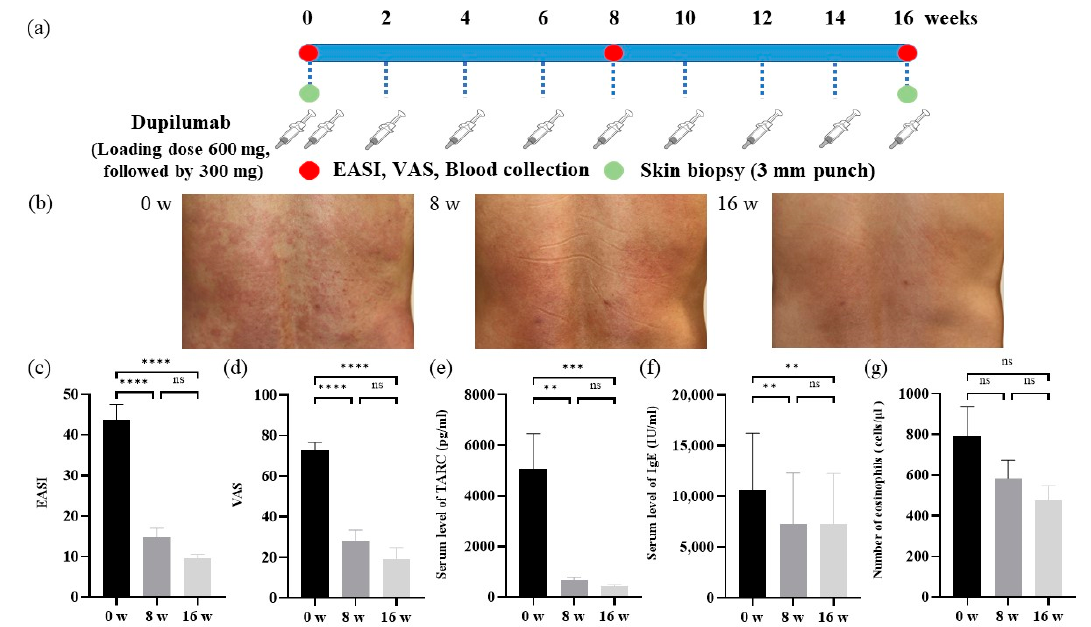
Figure 1. Experimental design and analysis of clinical scores in AD patients before and after the dupilumab treatment. ( a ) Experimental design. ( b ) Skin manifestations. 0 weeks ( left ). 8 weeks ( middle ). 16 weeks ( right ). ( c ) The EASI score. ( d ) The VAS scores. ( e ) TARC and ( f ) IgE serum levels. ( g ) Number of eosinophils in peripheral blood. Data are shown as the mean ± standard error of the mean (n = 12 per group). Statistical analyses were performed with Tukey’s multiple comparison test. ** p < 0.01, *** p < 0.001, **** p < 0.0001. EASI, eczema area and severity index; VAS, visual analogue scale; TARC, thymus and activation-regulated chemokine; IgE, immunoglobulin E; ns, not signifi- cant.